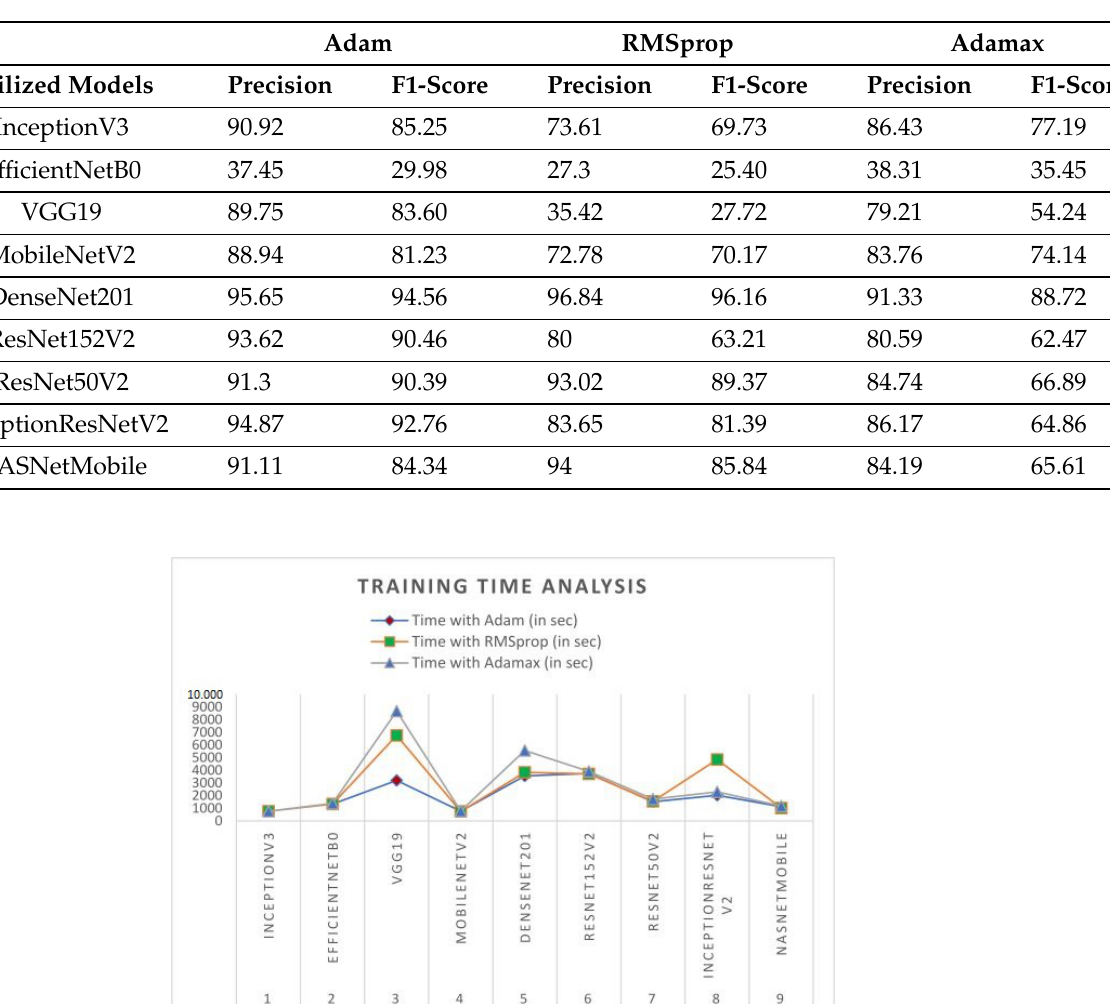
Table 3. Comparative analysis of classification metrics obtained using transfer-learning techniques with several optimizers.